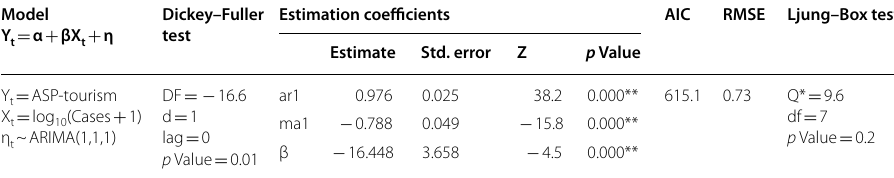
Table 4 Result of the dynamic regression model: explanatory variable “cumulative number of